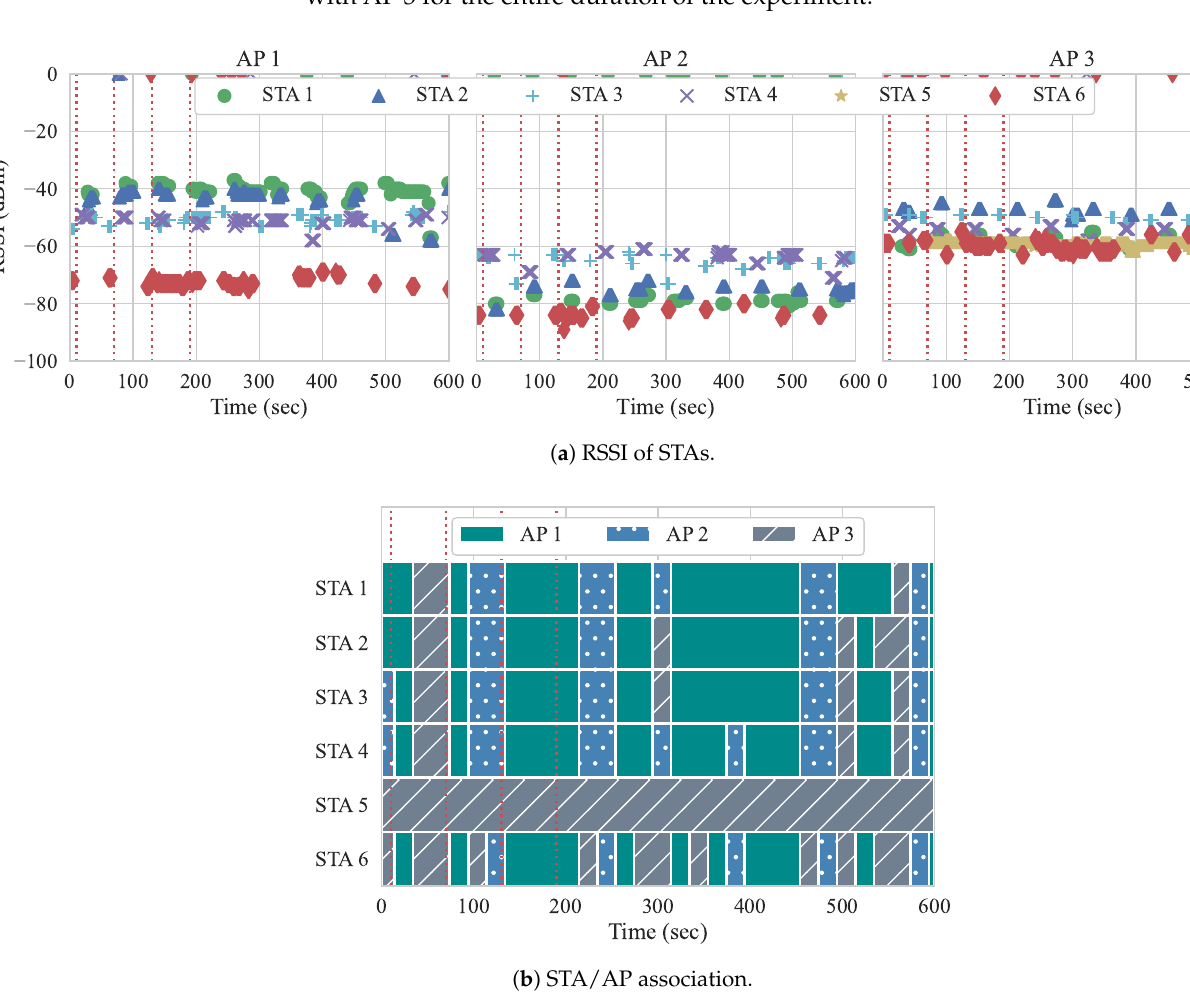
Figure 14. RSSI of STAs per AP running the workload of experiment 2 with Gómez et al.